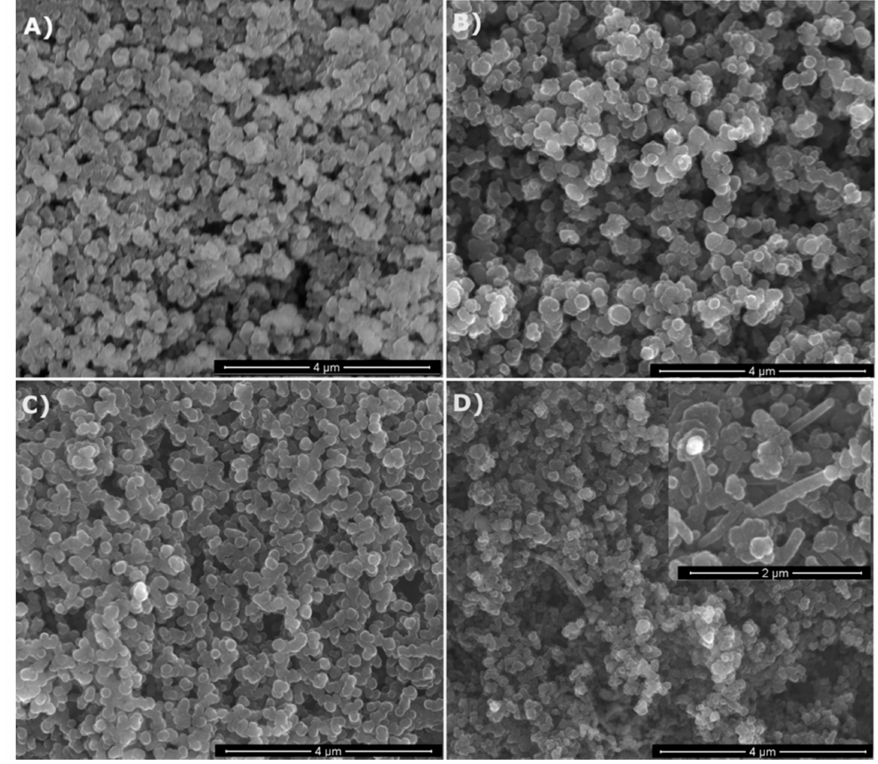
Figure 2. SEM images of selected powders prepared from methyltrimethoxysilane (MTMS): ( A )—1200 ◦ C/NH 3 , ( B )—1200 ◦ C/N 2 , ( C )—1600 ◦ C/NH 3 , ( D )—1600 ◦ C/N 2 (note higher mag- nification of the